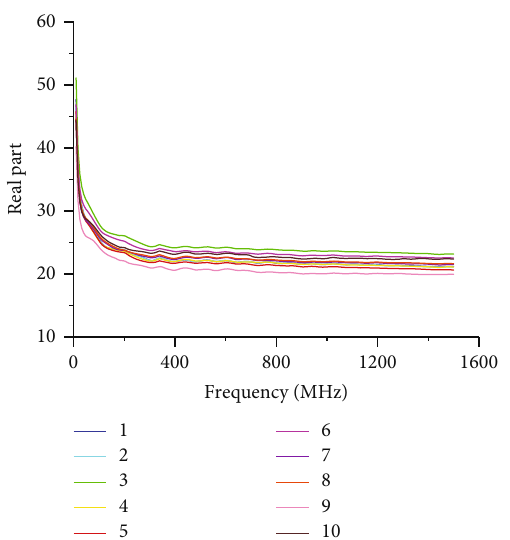
Figure 3: The real part of sample #5 dielectric permittivity changing with frequency under 10 repeated measurements.